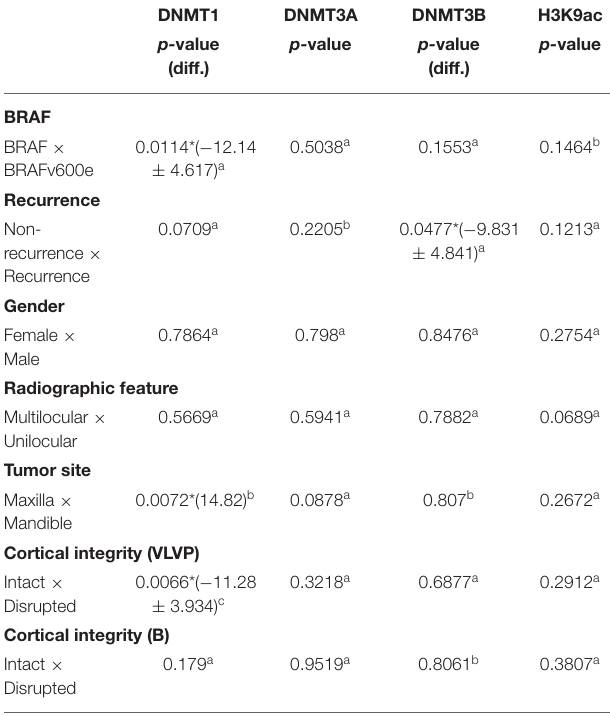
TABLE 2 | Comparison among the presence of BRAFv600e mutation and clinical and radiographic features in the AMEtma group. DNMT1 DNMT3A DNMT3B H3K9ac p- value p- value p- value (diff.)